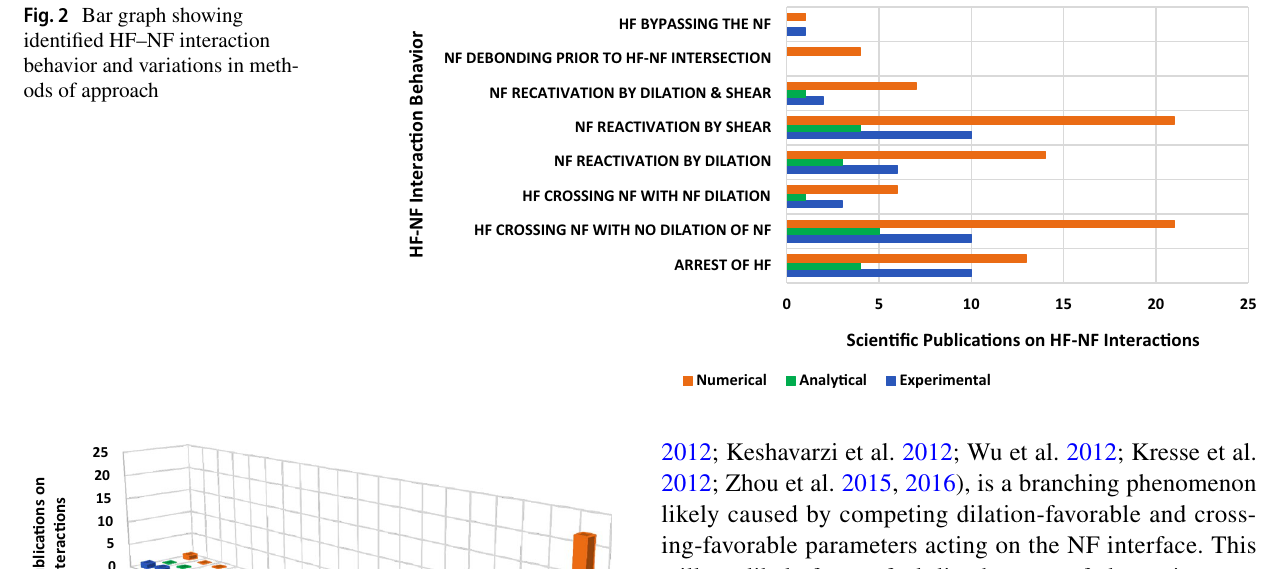
Fig. 2 Bar graph showing identified HF–NF interaction behavior and variations in meth-